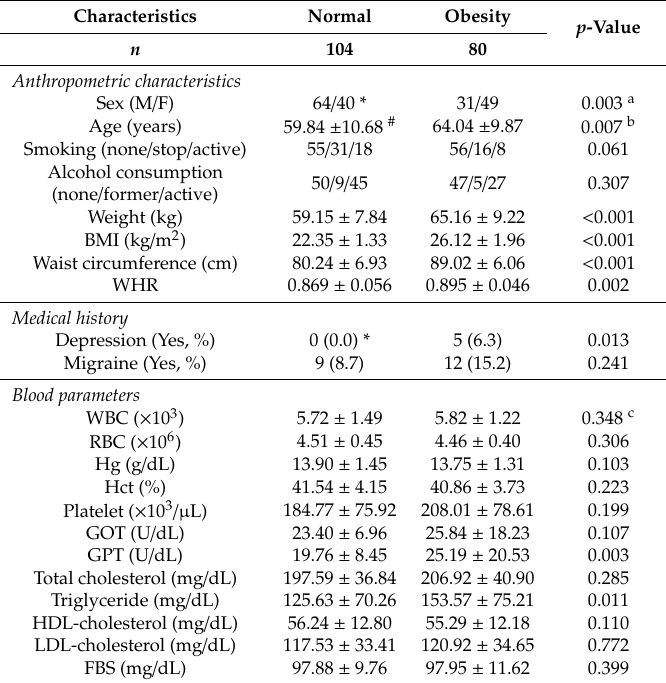
Table 1. Characteristics of normal and overweight / obese